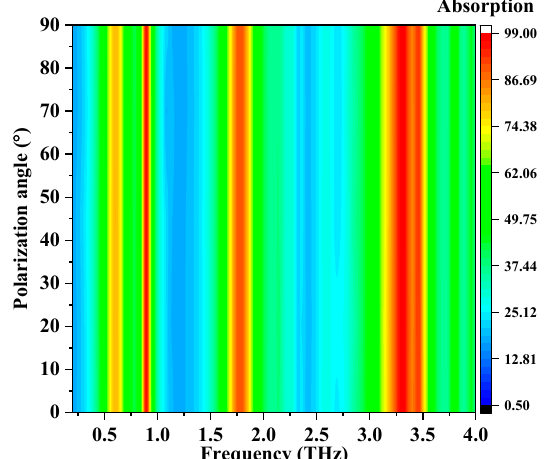
Figure 5. Absorption versus frequency with different polarization angles.